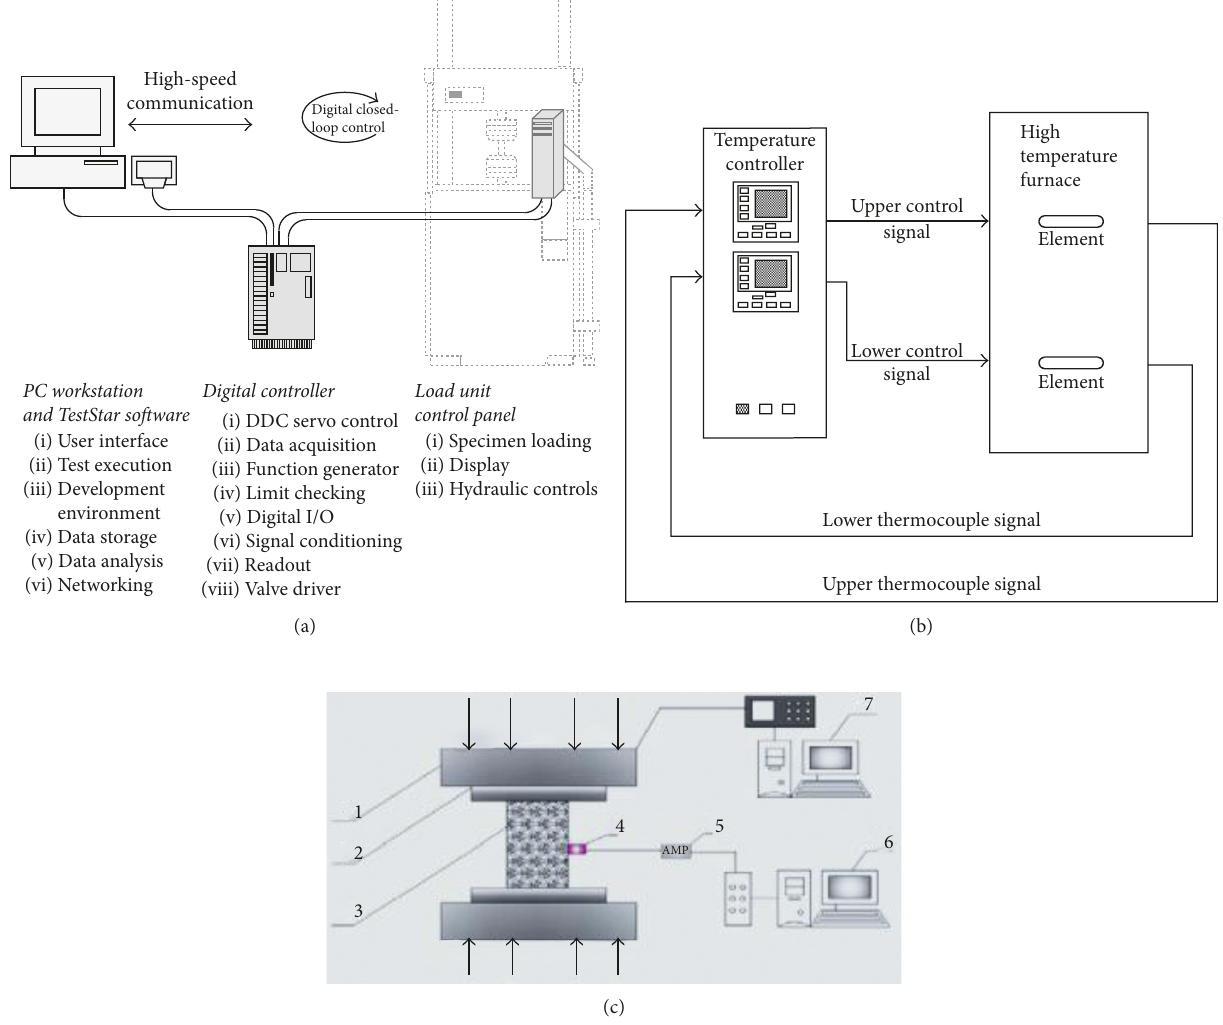
Figure 2: Schematic of the experimental system. (a) System diagram of MTS810. (b) Temperature controller/furnace block diagram of MTS652.02. (c) 1: compression testing machine; 2: insulation pads; 3: granite sample; 4: AE probe; 5: preamplifiers; 6: AE data acquisition and processing system; 7: load control system